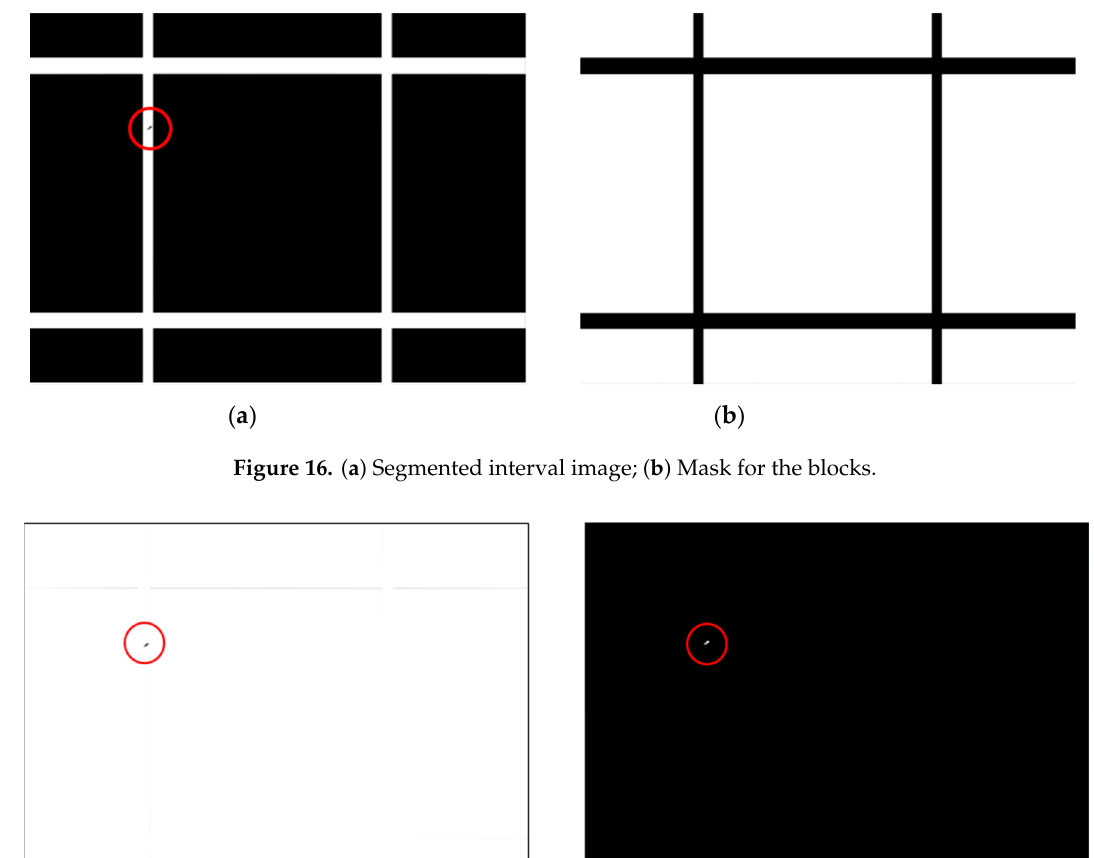
Figure 15. Flow of defect detection in intervals.